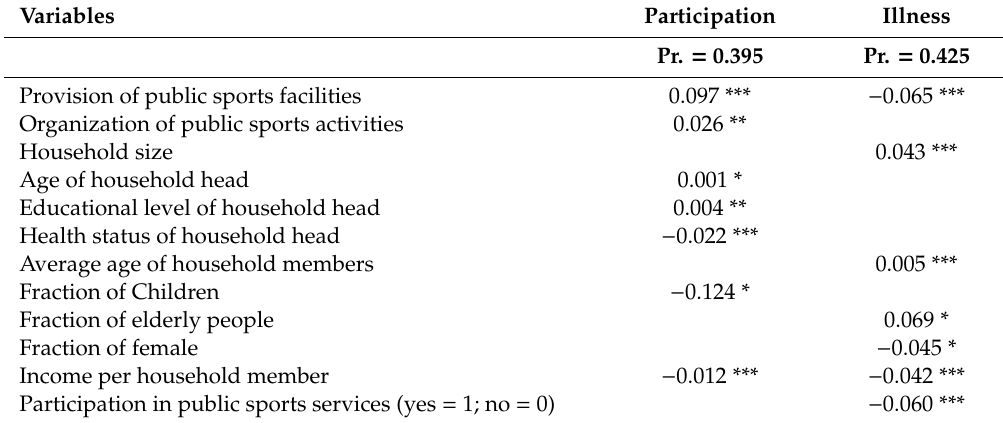
Table 5. E ff ects of statistically significant variables in recursive bivariate probit (RBP)